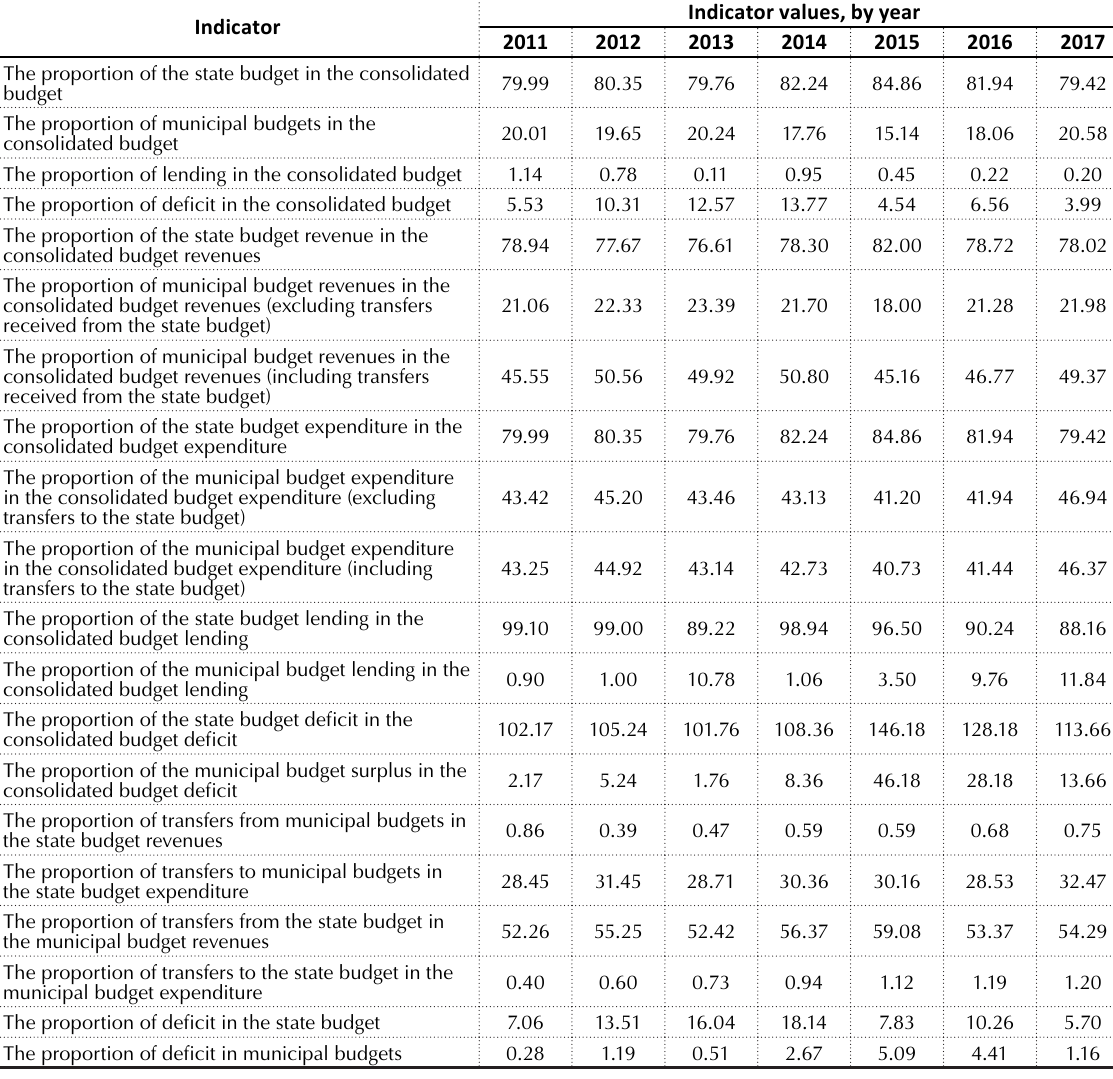
Table 1. Characteristics of the structure of consolidated, state and municipal budgets of Ukraine in 2011–2017, %